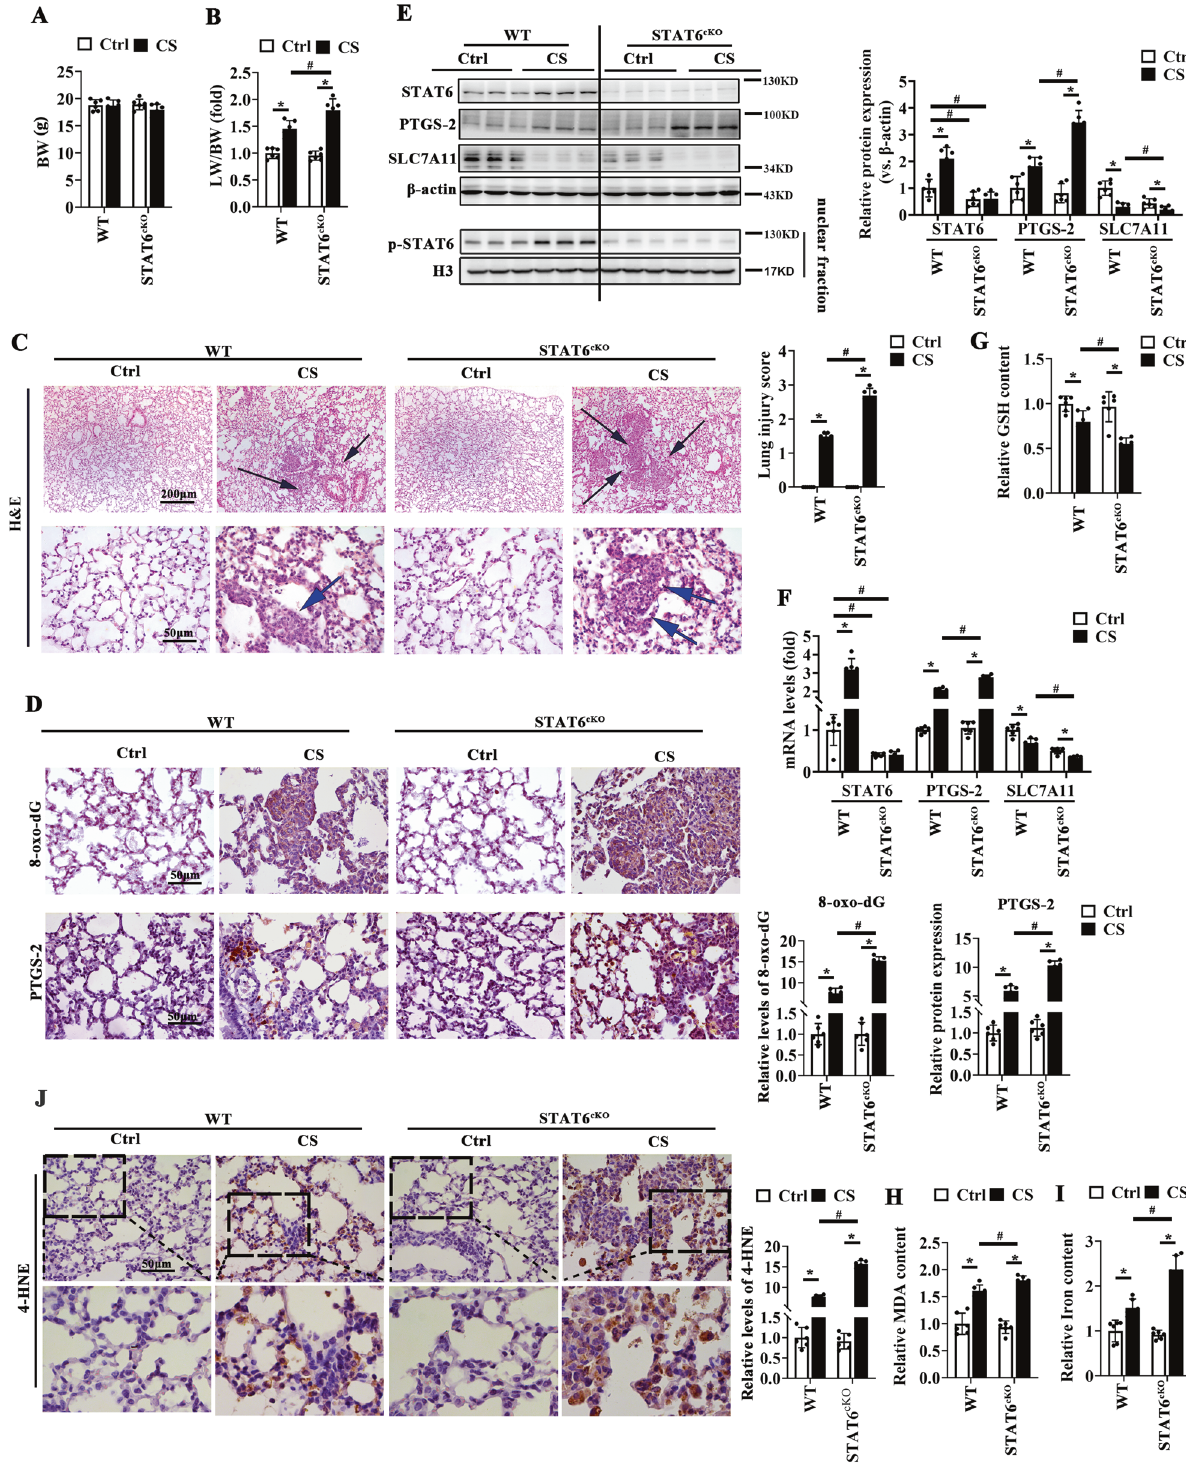
Fig. 2 STAT6 de fi ciency in lung epithelium aggravates CS-induced ferroptosis and lung injury. Wild type (WT) and lung epithelium-speci fi c STAT6 de fi ciency mice (STAT6 cKO ) mice were intratracheally instilled with CS and sacri fi ced 7 days later. A Body weight (BW) and B the ratio of lung weight to BW were determined. C Representative H&E-stained lung sections from WT and STAT6 cKO mice and lung injury score. (Black and blue arrows indicated in fl ammatory nodules and in fl ammatory cells in fi ltration respectively). D IHC staining of 8-oxo-dG and PTGS-2 of lung sections from indicated group were performed and quanti fi ed. Representative images from each group were shown. The protein expression ( E ) and mRNA F levels of STAT6, PTGS-2 and SLC7A11 in lung tissue were determined by western blot analysis and qRT-PCR assay. The relative GSH G , MDA ( H ) and Iron I content were measured by corresponding kit. J IHC staining of 4-HNE in lung sections from indicated group were performed and quanti fi ed. Representative images from each group were shown. The data were presented as means± SD ( n = 6, * p < 0.05, Ctrl vs . CS; # p < 0.05, WT vs . STAT6 cKO ).